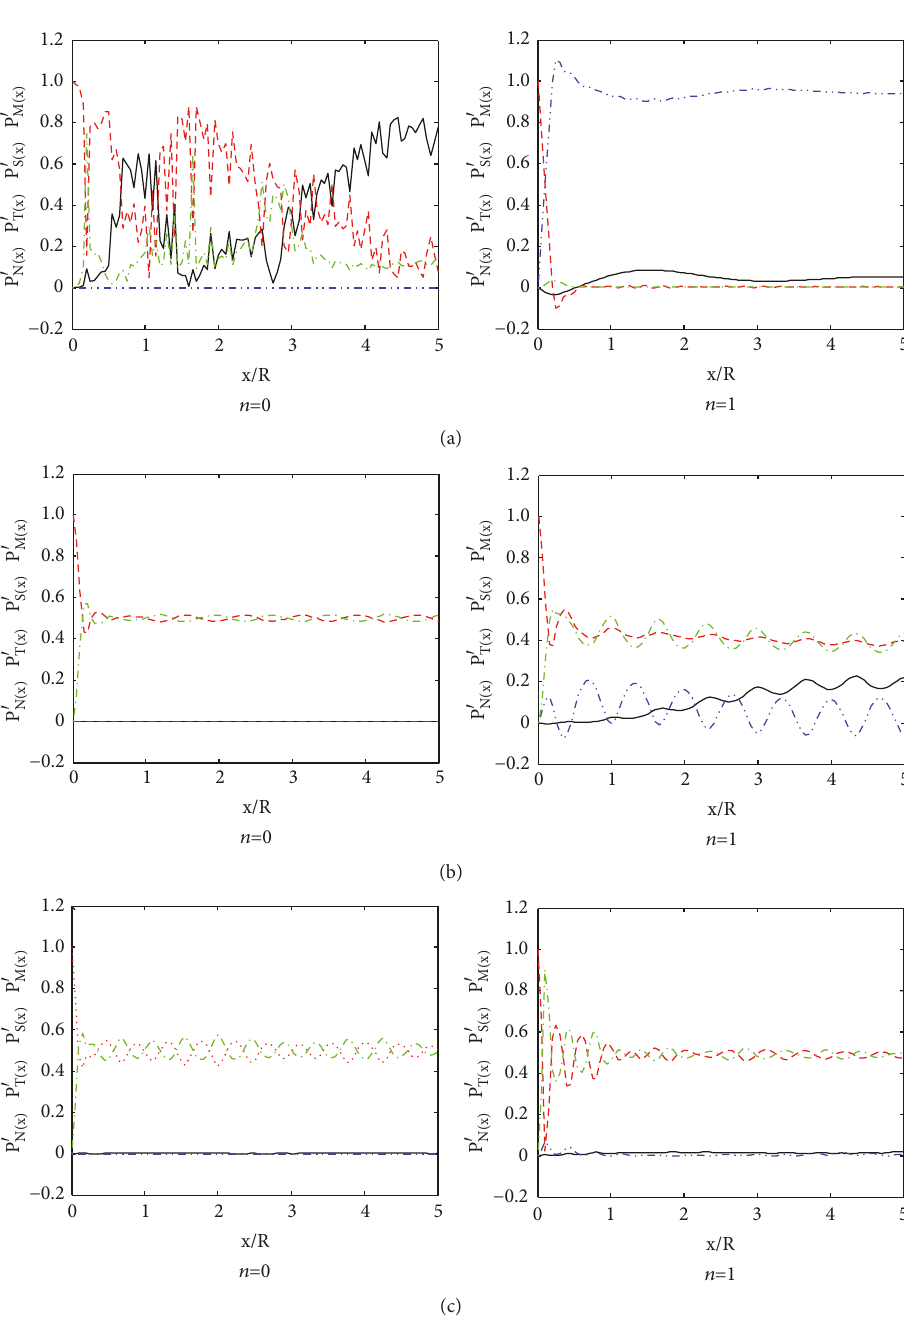
Figure 6: Power transmitted by different shell forces (moments) with cross-ply [90 ∘ /0 ∘ /90 ∘ ]: (a) Ω = 0.3 , (b) Ω = 1.2 , and (c) Ω = 3.0 ; black solid line: 𝑃 󸀠 𝑆(𝑥) ; blue dashed double dotted line: 𝑃 󸀠 𝑇(𝑥) ; red dashed line: 𝑃 󸀠 𝑆(𝑥) ; green dashed dotted line: 𝑃 󸀠 𝑀(𝑥)